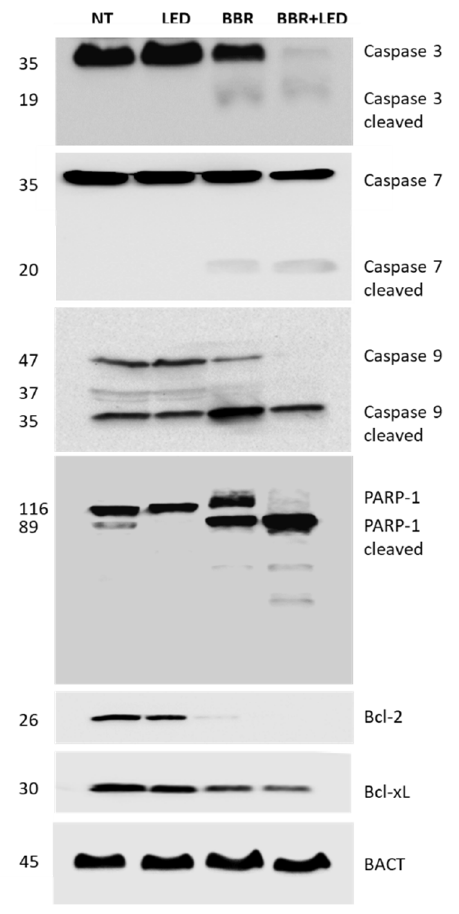
Figure 8. Expression of apoptotic markers. Protein expression in untreated (NT), LED stimulated (LED), BBR (200 μ g/mL for 4 h) treated, and BBR + LED exposed T98G cells were evaluated after 24 h p.t. by immunoblotting. For each sample, 40 μ g of total protein extracts was loaded into 10% (for PARP-1) and 12% polyacrylamide gels. All the experiments were performed in triplicate with independent assays. A representative experiment is shown. Molecular weights in KDa are reported.